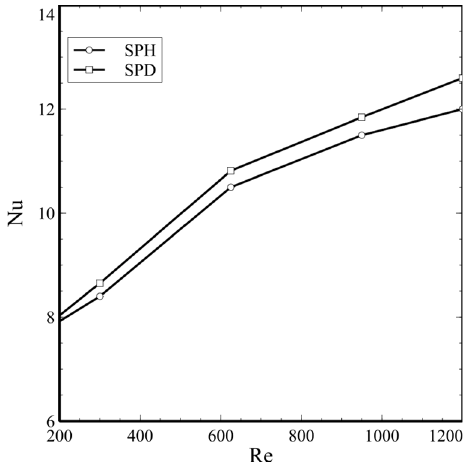
Figure 16. Comparison of Nu with literature: Al 2 O 3 -water nanofluid at 𝜙 (cid:3029) = 4% for SPH and SPD.